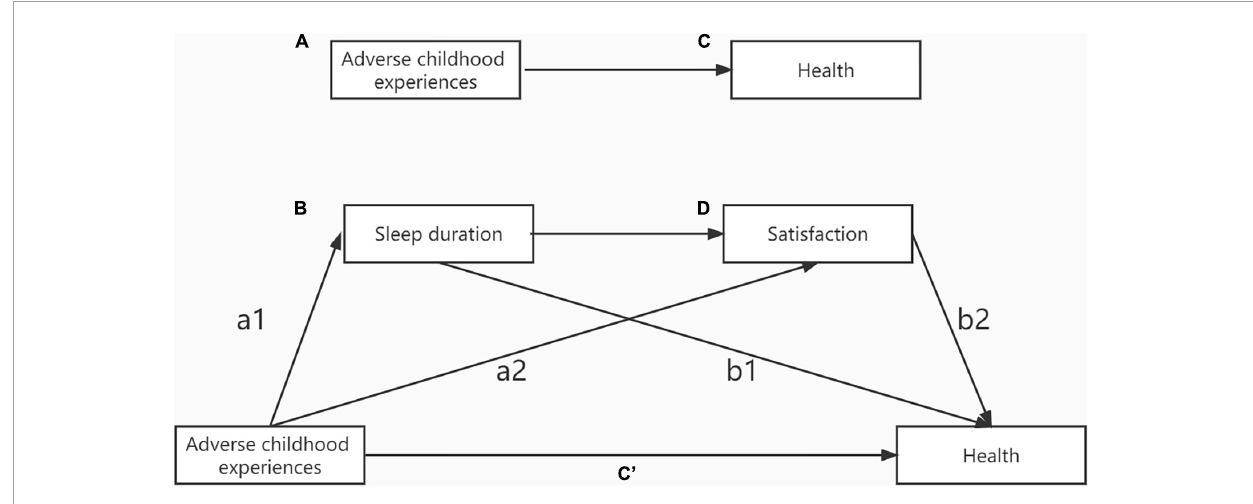
FIGURE1 (A) The direct relationship between adverse childhood experiences and (C) health levels. (B) Sleep and (D) satisfaction mediate the relationship between adverse childhood experiences and health.